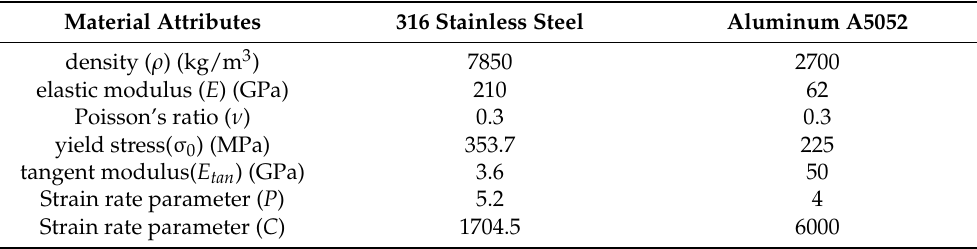
Table 2. Material attributes of 316 stainless steel and aluminum A5052.